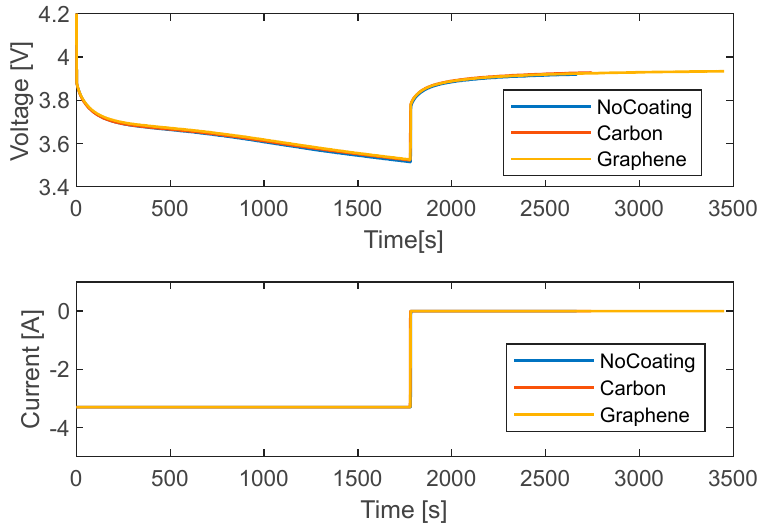
Figure 5. Curves of current and voltage versus time for the discharge tests at 1C with different coatings.